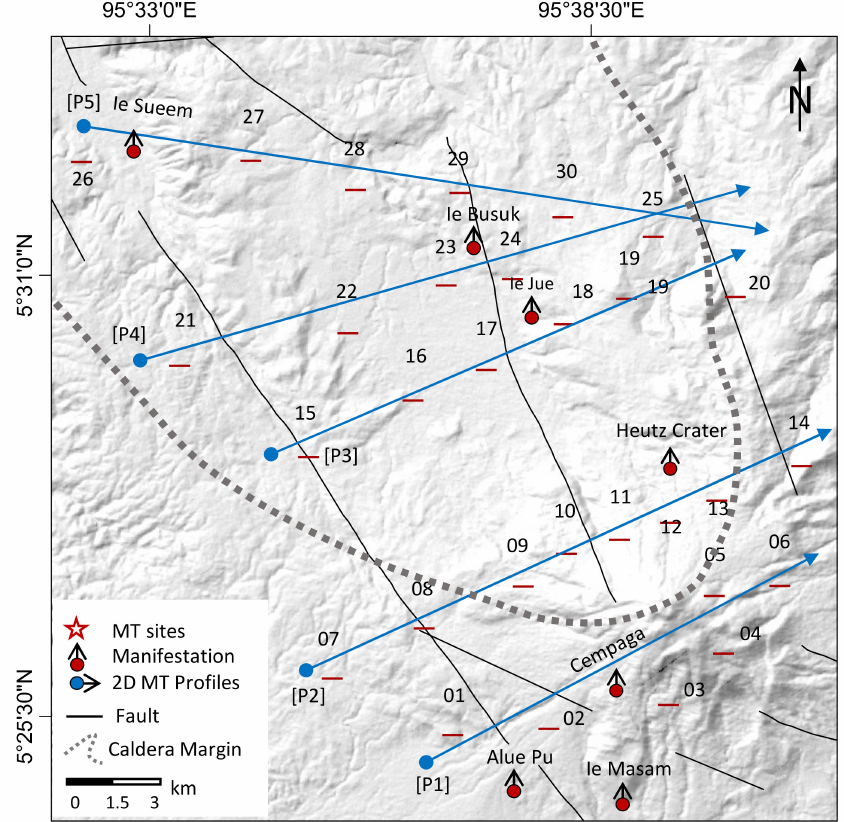
Figure 3. Topographic map showing the distribution of MT sites intersecting several local faults spread across the Seulawah Agam volcano. These MT stations cover the distribution of manifestations from Ie Masam to Ie Suum, which form the caldera margin